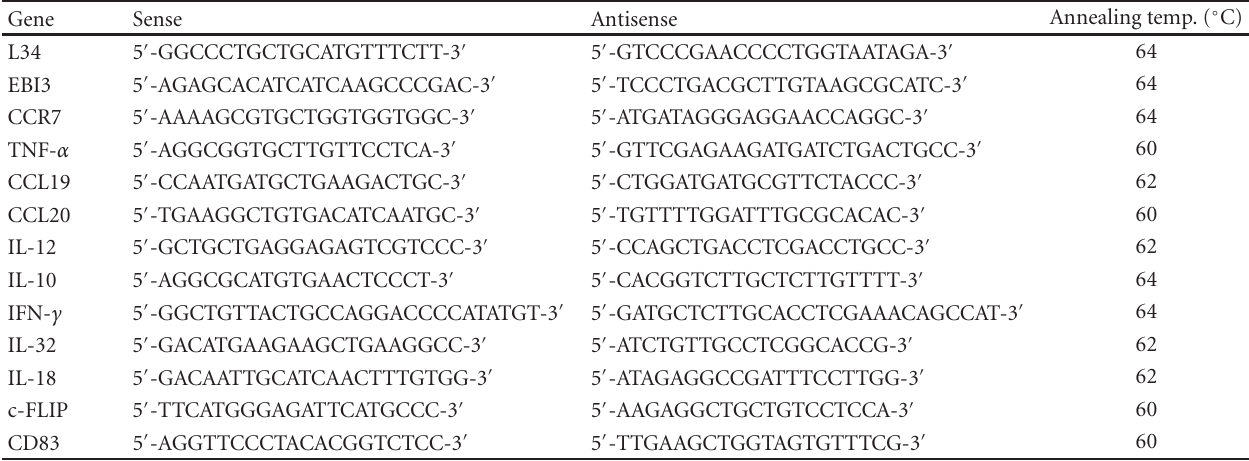
Table 1: Primer sequences used in the q-rt